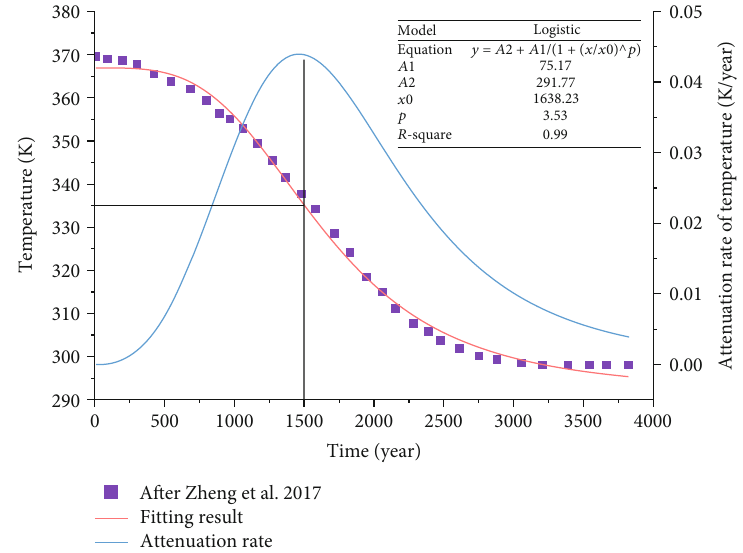
Figure 1: Temperature attenuation curve of nuclear